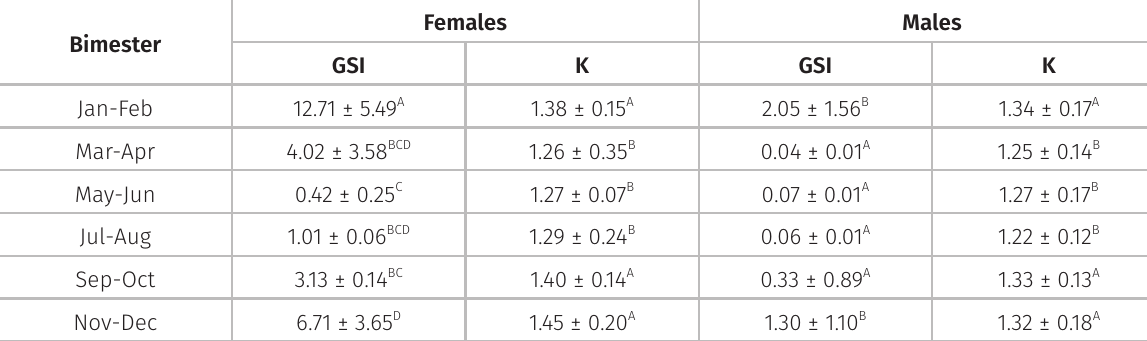
Data expressed as mean ± standard deviation (SD). Different letters in same line = differences between males and females (p < .05). Table III. The average values per bimester of gonadosomatic índice (GSI) and condition factor (K) of S. elegans females and males captured in the São Francisco River between January and December